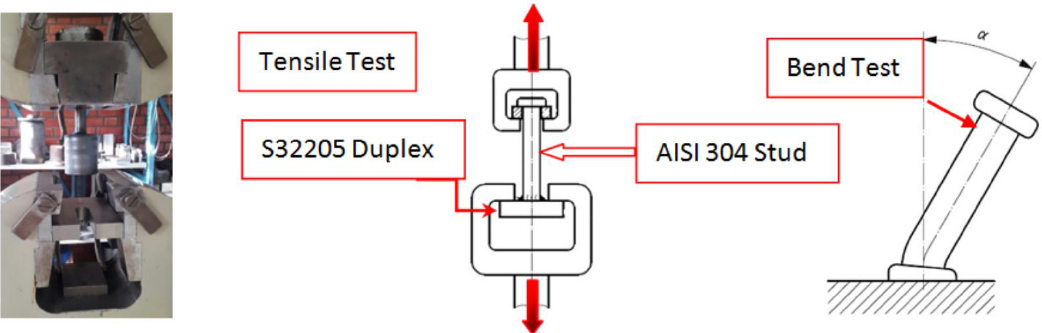
Figure 12. Tensile and bending test apparatus according to ISO 14555 standard.